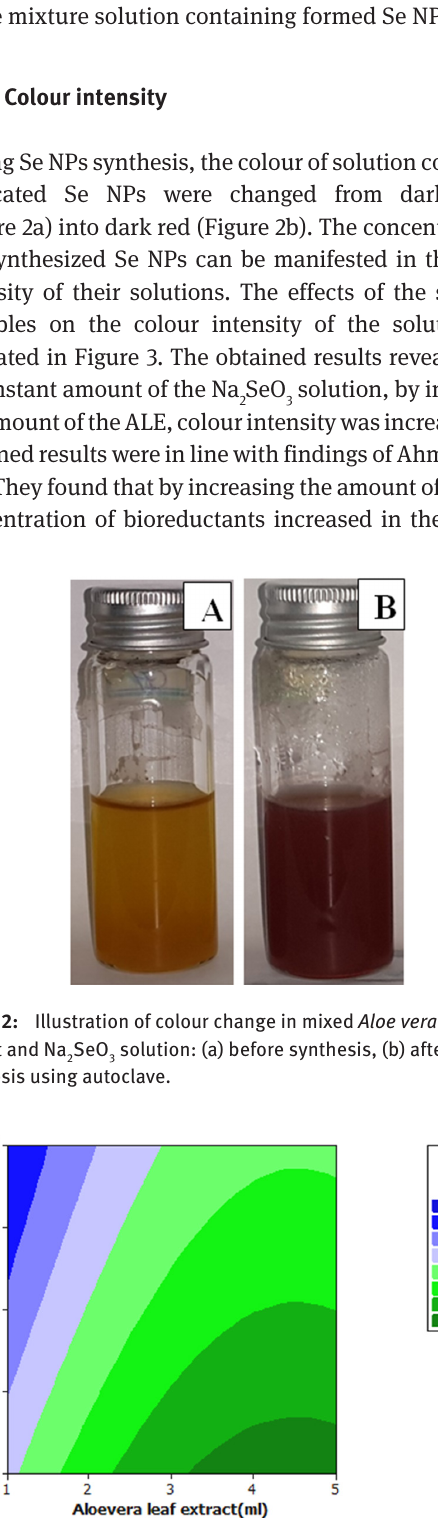
SeO solution and Aloe vera leaf 2 3